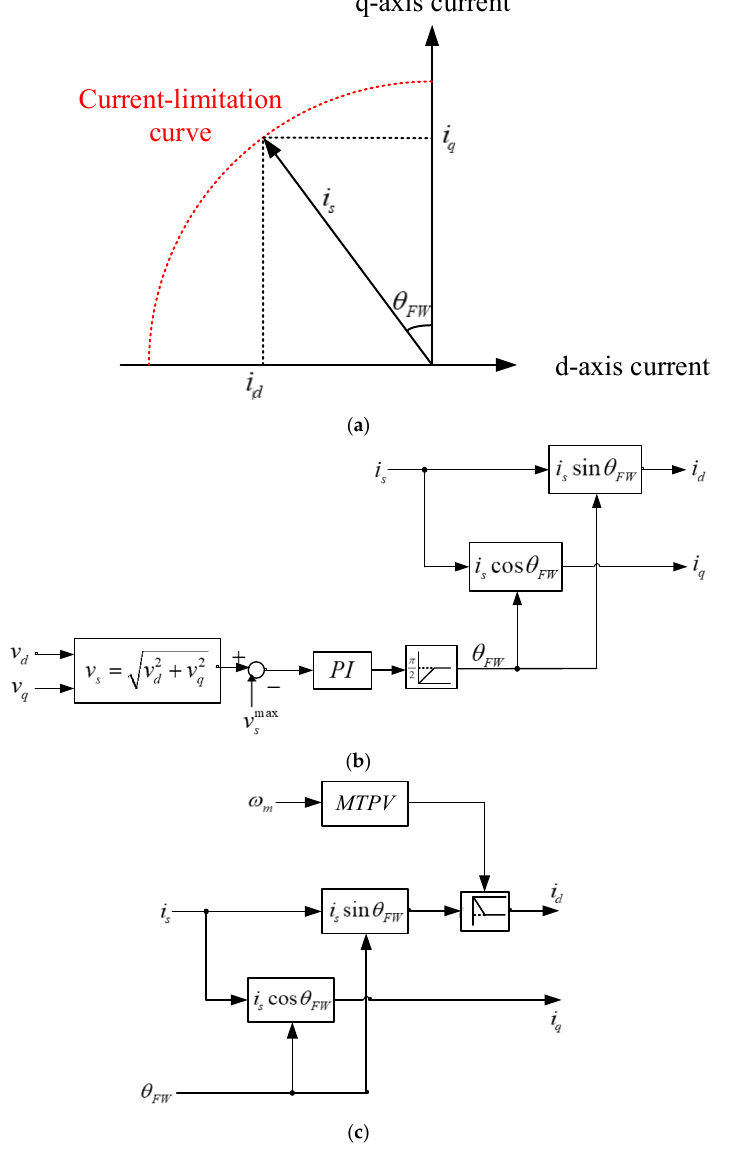
Figure 7. Flux-weakening and MTPV control. ( a ) d-q axis current curve, ( b ) flux-weakening control, ( c ) MTPV control.